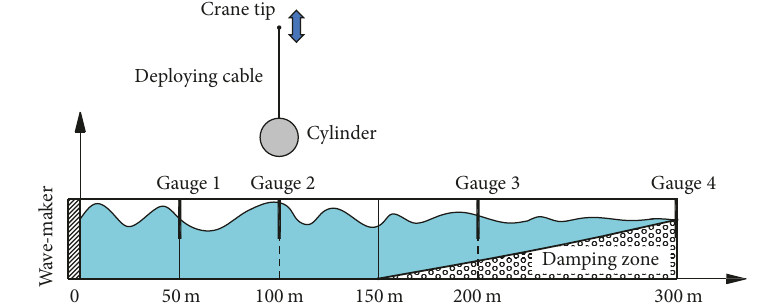
Figure 4: A schematic of numerical wave tank.